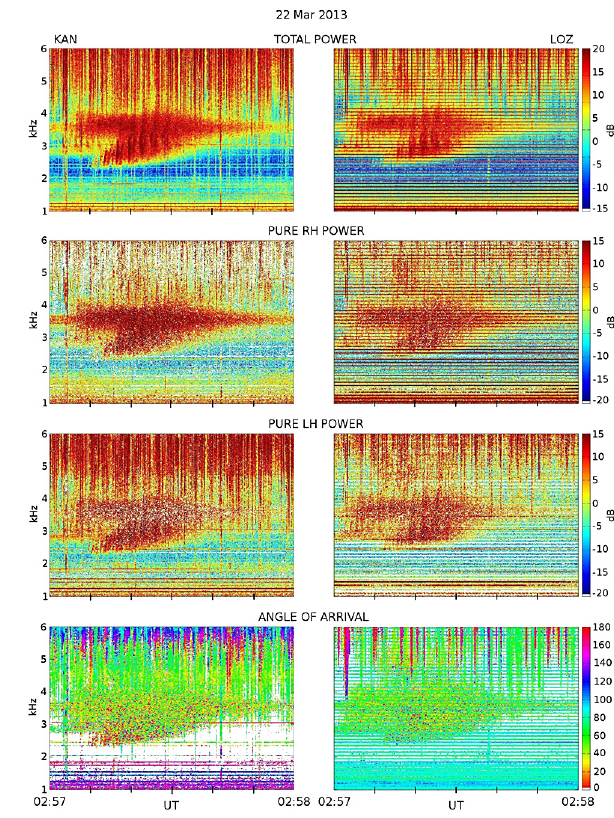
Figure 6. Short-lasting hiss-like VLF emissions observed at KAN and LOZ at 04:32–04:33UT on 31 March 2013. There is a clear difference in the polarization of the event between our